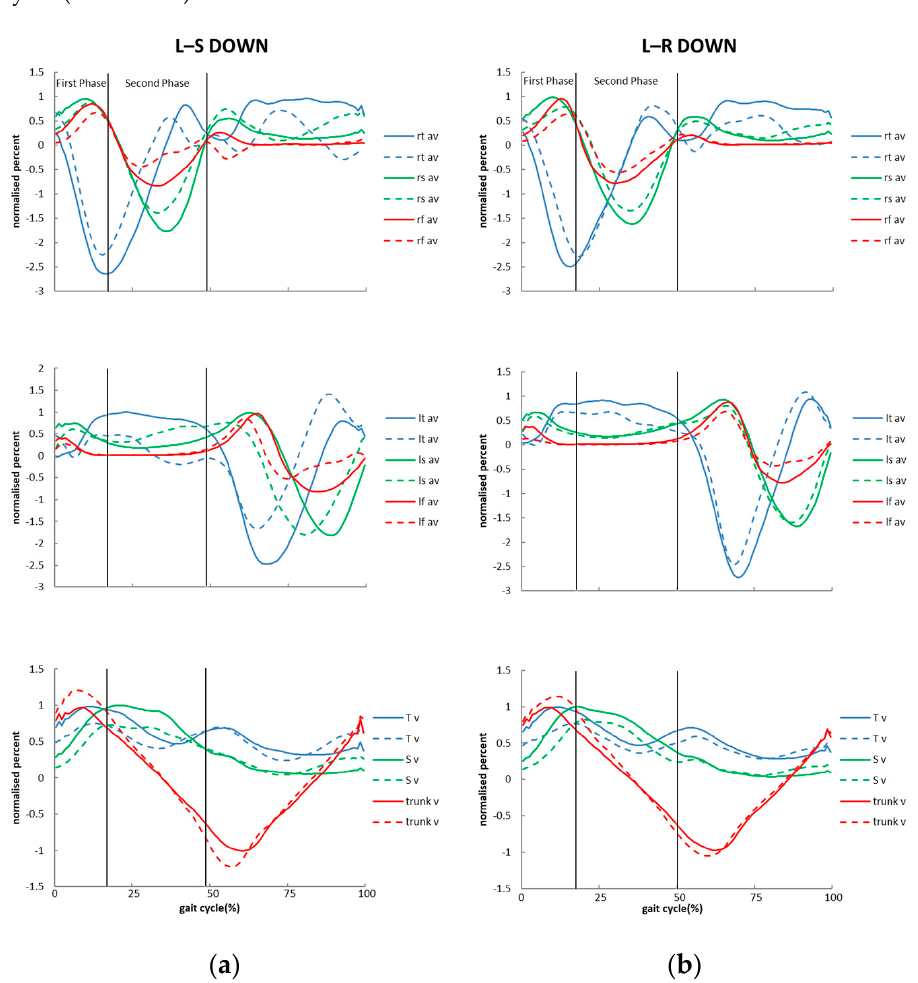
Figure 5. Average profile of the parameters: ( a ) during L-S DOWN and ( b ) during L-R DOWN. rt indicates the hip of leading limb, lt indicates the hip of trailing limb, rs indicates the knee of leading limb, ls indicates the knee of trailing limb, rf indicates the ankle of leading limb, lf indicates the ankle of trailing limb, trunk is trunk, T indicates the thigh of the leading limb, S indicates the shank of the leading limb, aa indicates angular acceleration, av indicates angular velocity, a indicates acceleration, and v indicates velocity. The dashed lines indicate transition stride. The solid lines indicate the stride before transition